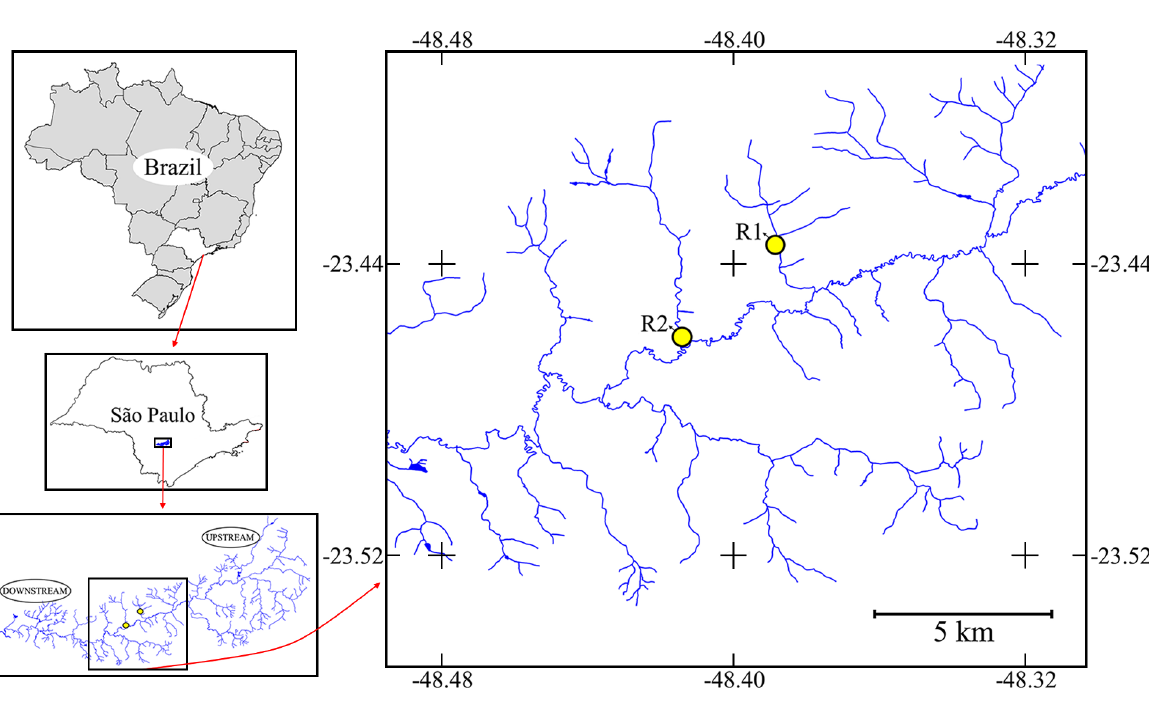
Figure 1. Sampling reaches (R1 and R2) in the Guareí River system - map modified from Azevedo-Santos et al.